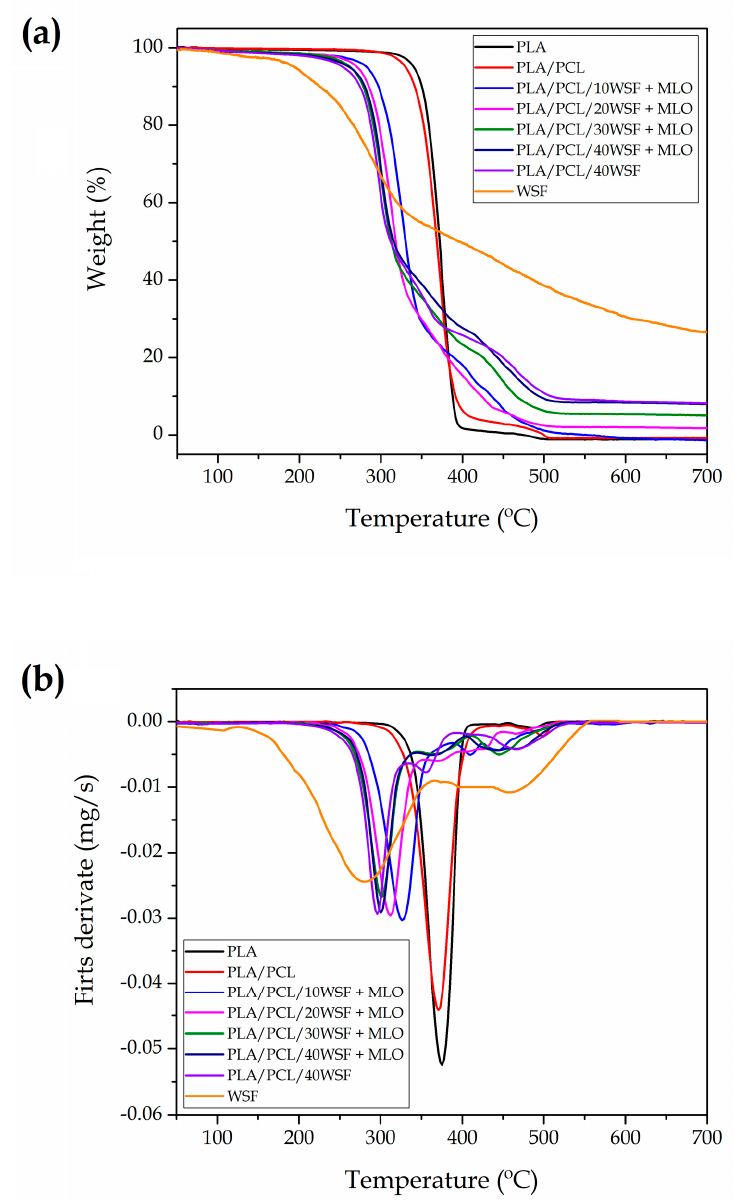
Figure 5. ( a ) Thermogravimetric analysis (TGA) and ( b ) first derivative (DTG) curves of the green composites made of polylactide (PLA), poly( ε -caprolactone) (PCL), walnut shell flour (WSF), and maleinized linseed oil (MLO).